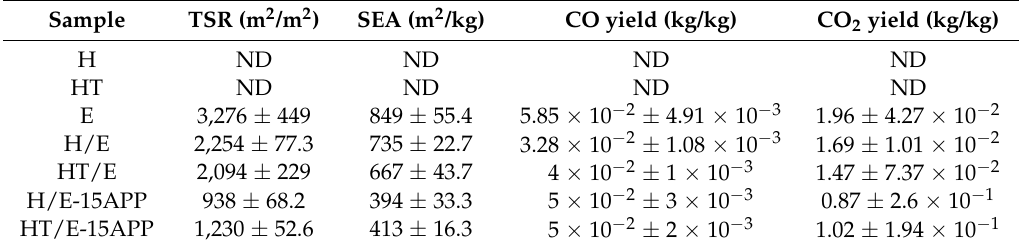
Table 4. Smoke results from cone calorimetry tests performed on hemp and on the different composites before and after the waterglass treatment. TSR, total smoke release; SEA, specific extinction area; ND, not detectable.